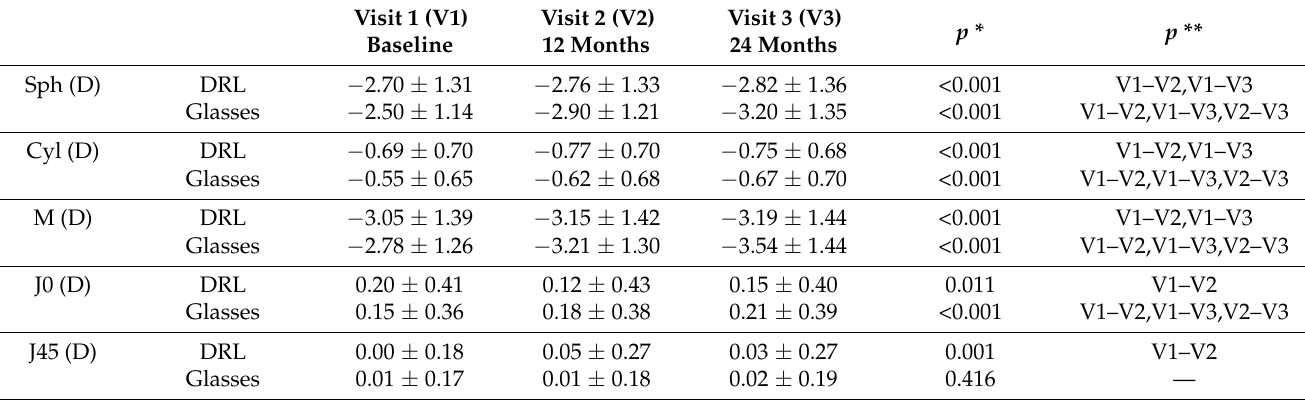
Table 5. Data from the longitudinal study at 12 and 24 months of treatment in the comparison between DRL and glasses. Inter-visit analysis with Bonferroni adjustment test presented.